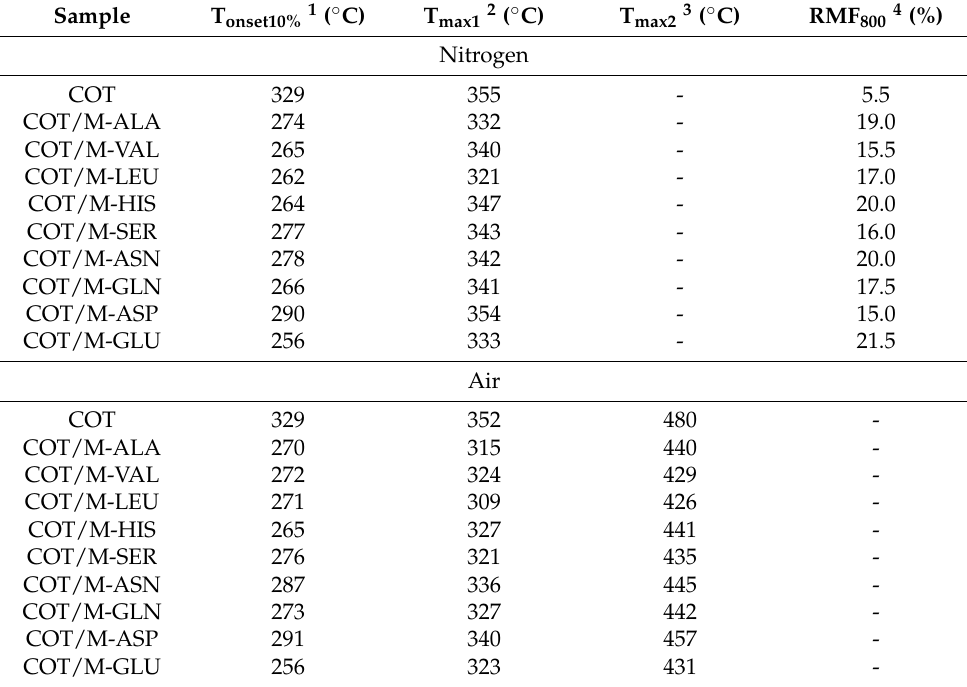
Figure 5. TG thermograms of untreated cotton and 7% add-on, PAA-treated cotton fabrics in nitrogen ( a ) and air ( b ). Table 5. Thermal data of untreated cotton and 7% add-on, PAA-treated cotton fabrics in nitrogen and air obtained by thermogravimetric analysis.